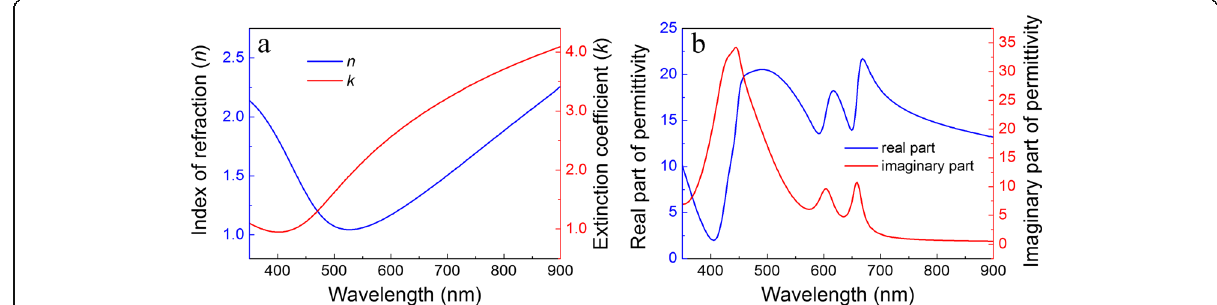
Fig. 2 a Dispersion of TiN layer: n is the refractive index and k extinction coefficient. b Dispersion of monolayer MoS 2